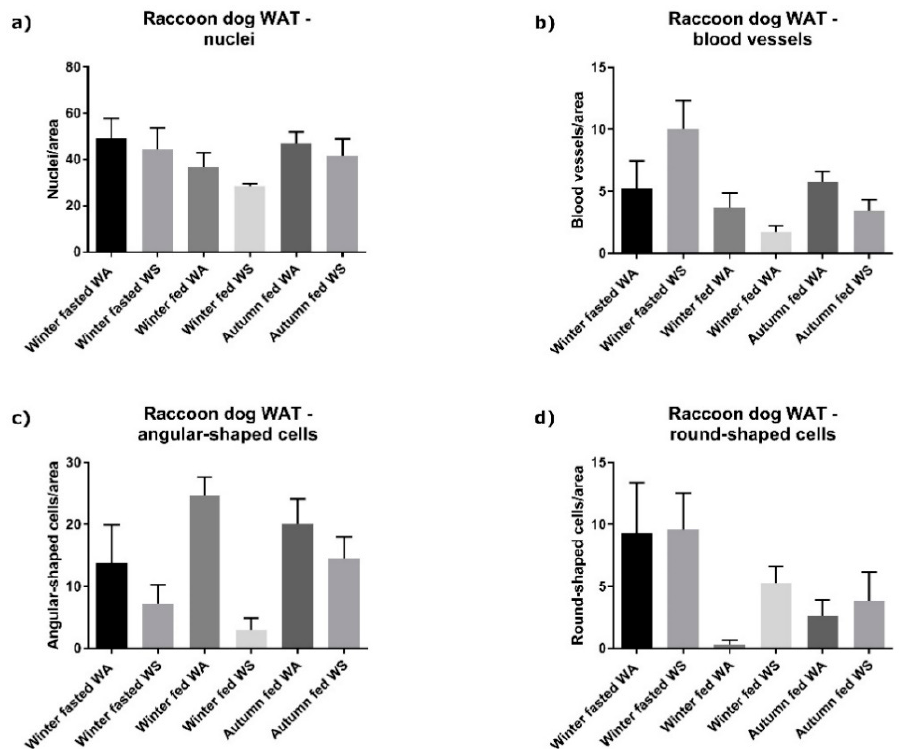
Figure 3. Histopathological analysis of raccoon dog WAT samples. ( a ) Amount of nuclei per area, ( b ) vascularization as amount of blood vessels per area and ( c , d ) shape profile of the adipocytes.